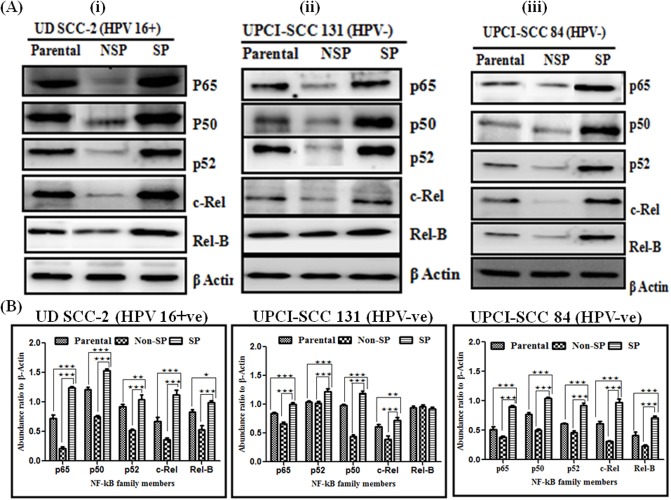
Differential expression pattern of NF-κB family proteins in OSCC cell lines.A. Western blot analysis of NF-κB family proteins in cellular protein extracted from sorted SP, NSP and parental cells from (i)UD-SCC2 HPV16+, (ii) UPCI:SCC131 and (iii) UPCI:SCC84 cell line. A total of 25 μg protein extracts each from SP, NSP and parental cells were separated on a 10% SDS-PAGE, electrotransferred on PVDF membrane and probed for NF-κB family proteins p65, p50, p52, c-Rel and Rel-B. To confirm equal protein loading, the membranes were reprobed for β-actin expression. The relative normalized fold change in the protein is expressed as the mean ±SD of three independent experiments. B. Bar diagram showing NF-κB family proteins expression between SP cells, NSP cells and Parental cells from (i) UD-SCC2 HPV16+, (ii) UPCI:SCC131 and (iii) UPCI:SCC84 cell lines. ***P value <0.001, **P value <0.01, *P value <0.05.